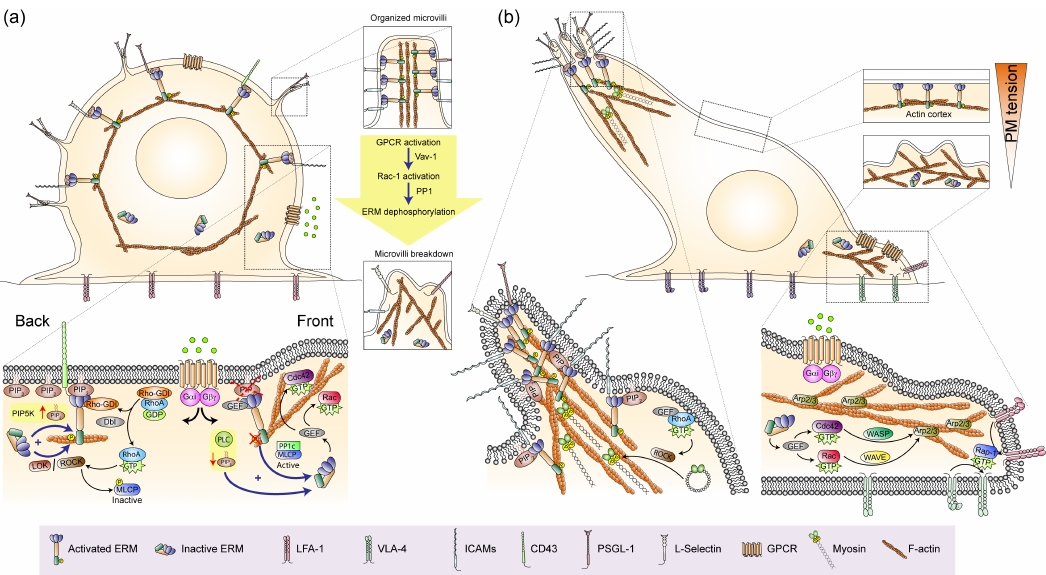
Figure 2. Compartmentalized activation of ERMs and small Rho GTPases in polarized motile leukocytes. ( a ) Initial symmetry breaking events in resting leukocytes stimulated with chemoattractants. In response to chemoattractants, G protein-coupled receptor (GPCR)-associated heterotrimeric proteins stimulate ERM activation at the cell rear through phosphorylation by the kinase activity of LOK and RhoA-stimulated ROCK, production of PIP 2 by PIP5K; and ERM inactivation at the cell front through PIP 2 hydrolysis by phospholipase C (PLC) and the phosphatase activity of the PP1 subunit of MLCP, which subsequently activates Rac and Cdc42 through the release of their corresponding guanine nucleotide exchange factors (GEFs). On the upper right, breakdown of microvilli by chemoattractant-stimulated Rac-1 activation is depicted. ( b ) Polarized motile leukocyte showing Rac- and Cdc42-stimulated actin polymerization by the Arp2 / 3 complex in the leading edge and RhoA-ROCK-mediated actomyosin contraction in the uropod, which provide the main forces required to move the cell forward. Rap-1-mediated β 1 (e.g., VLA-4) and β 2 (e.g., LFA-1) integrin activation in the leading edge and adhesion molecule-bearing microvilli on the uropod are also depicted. On the upper right, plasma membrane (PM) tension near the uropod and at the leading edge are